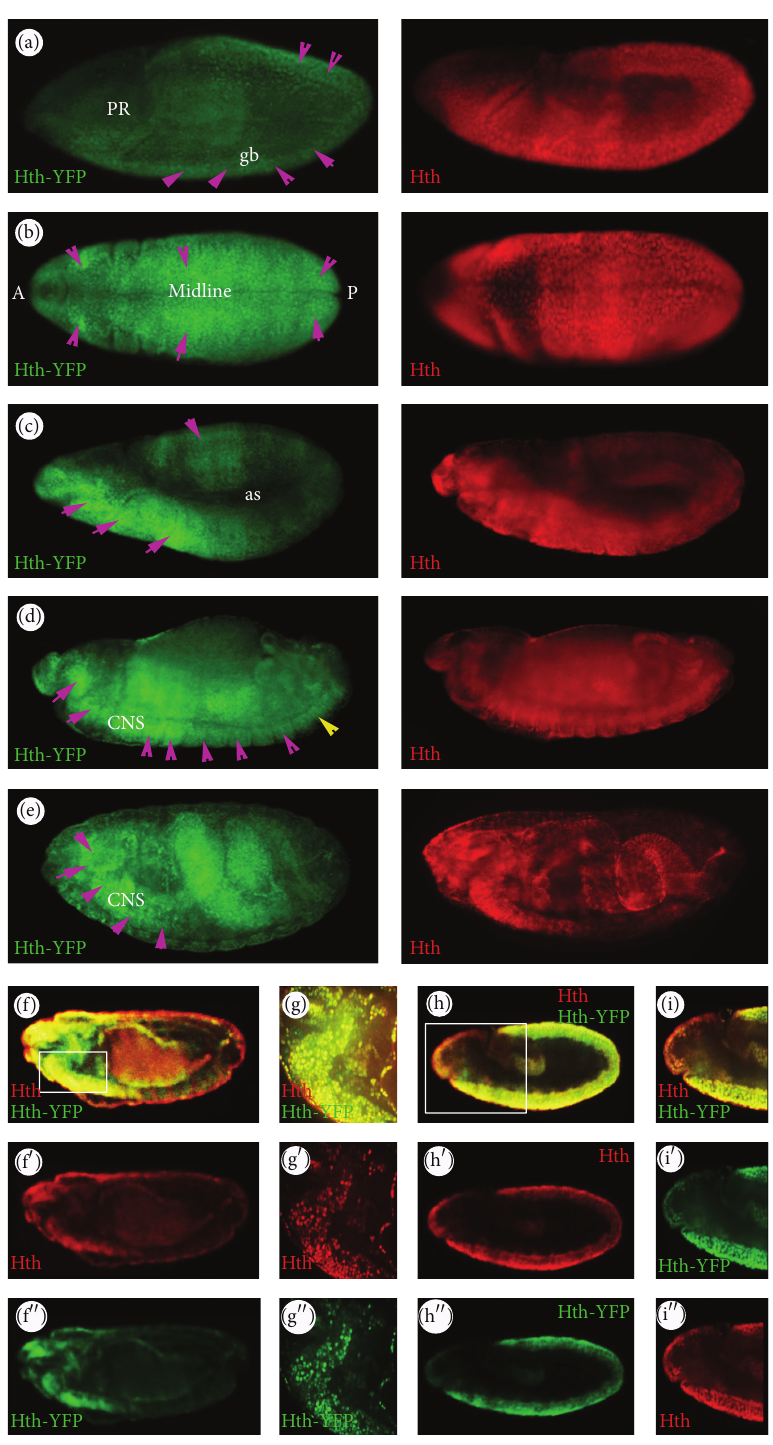
Figure 4: Patterns of Hth-YFP expression. ((a)–(e)) Left panels: Hth-YFP embryos, stained with 𝛼 -GFP antibodies; Hth-YFP expression is indicated by purple arrowheads. Right panels: the distribution of the endogenous Hth protein for the corresponding embryonic stages in the wild type. (a) Lateral view of a Stage 9 embryo, PR: procephalon, gb: germ band. (b) Dorsal view of a Stage 10 embryo. A: anterior and P: posterior. (c) Stage 11 embryo; Hth-YFP is strongly expressed anteriorly but declines posteriorly. (d) Stage 13 embryo. The posterior extent of the CNS is indicated by the yellow arrow. (e) Late stage of embryogenesis. Hth-YFP expression is prominent in the CNS of the Stage 15 and Stage 16 embryos but becomes weaker in the posterior regions. ((f)–(i 󸀠󸀠 )) Hth-YFP embryos stained with 𝛼 -GFP and 𝛼 -Hth antibodies. ((g)–(g 󸀠󸀠 )) High magnification of a region boxed in (f), whereas ((i)–(i 󸀠󸀠 )) are high magnifications of a region boxed in (h). Overall, the protein trap shows similar temporal and spatial expression patterns to the endogenous Hth protein in the